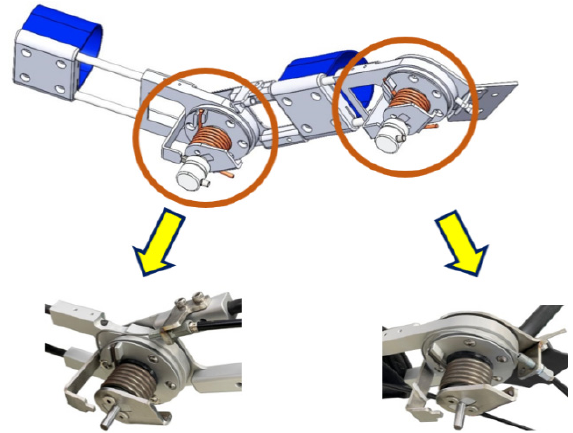
Figure 3. Joint structure diagram of the torsion spring module.